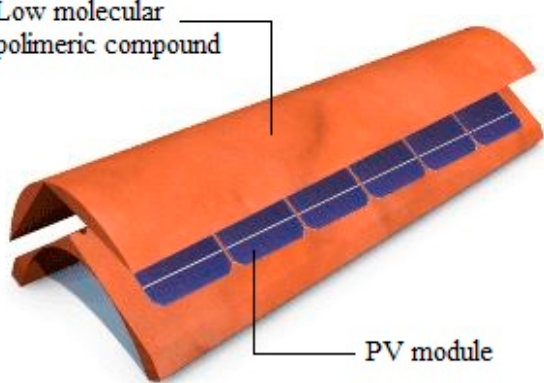
Figure 7. PV coppo with a polymeric compound developed to encourage the photon absorption (source [35]).